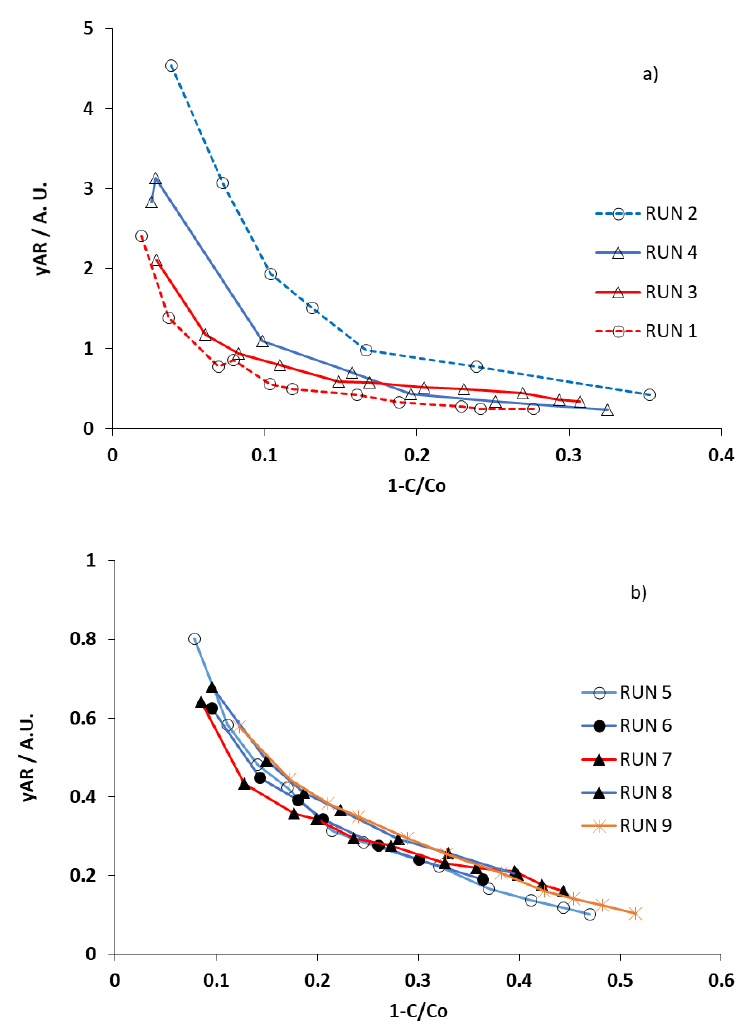
Figure 10. Values of yield of AR formation as a function of the removal of DRN obtained for the eight runs: panel ( a ) reports the results at C 0 = 10 ppm; panel ( b ) reports the results at C 0 = 20 ppm. Although arbitrary units, some indication can be derived from the reported trends of